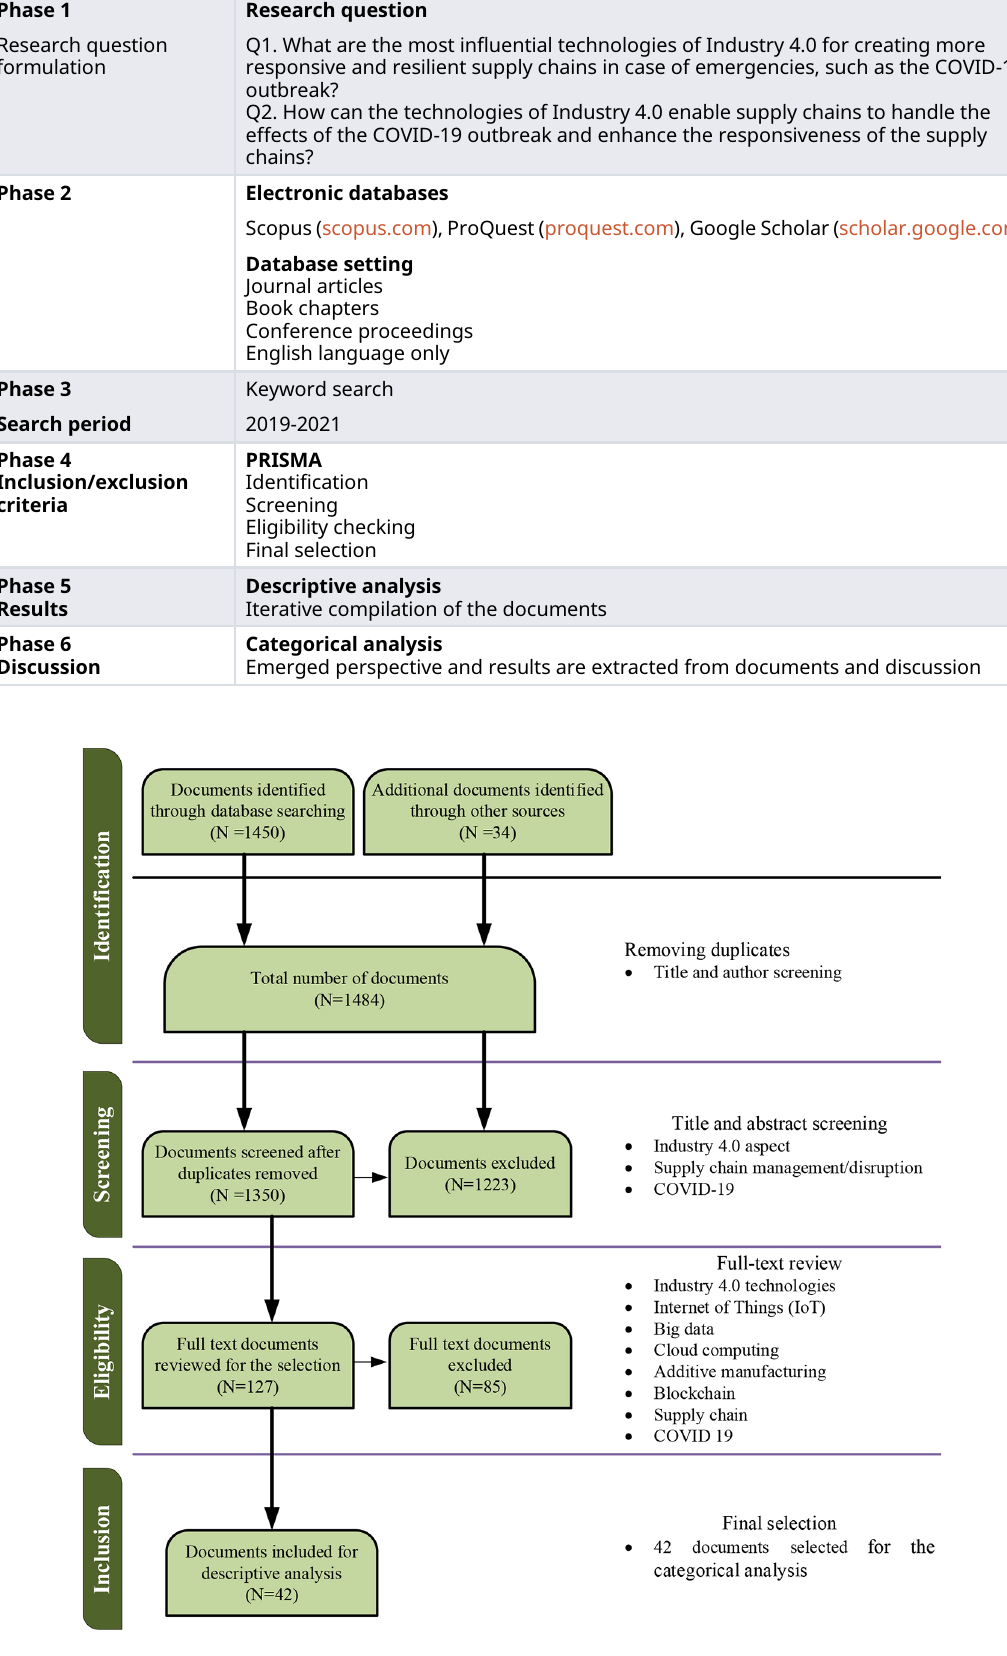
Figure 1. Preferred Reporting Items for Systematic Review and Meta-analysis Protocols